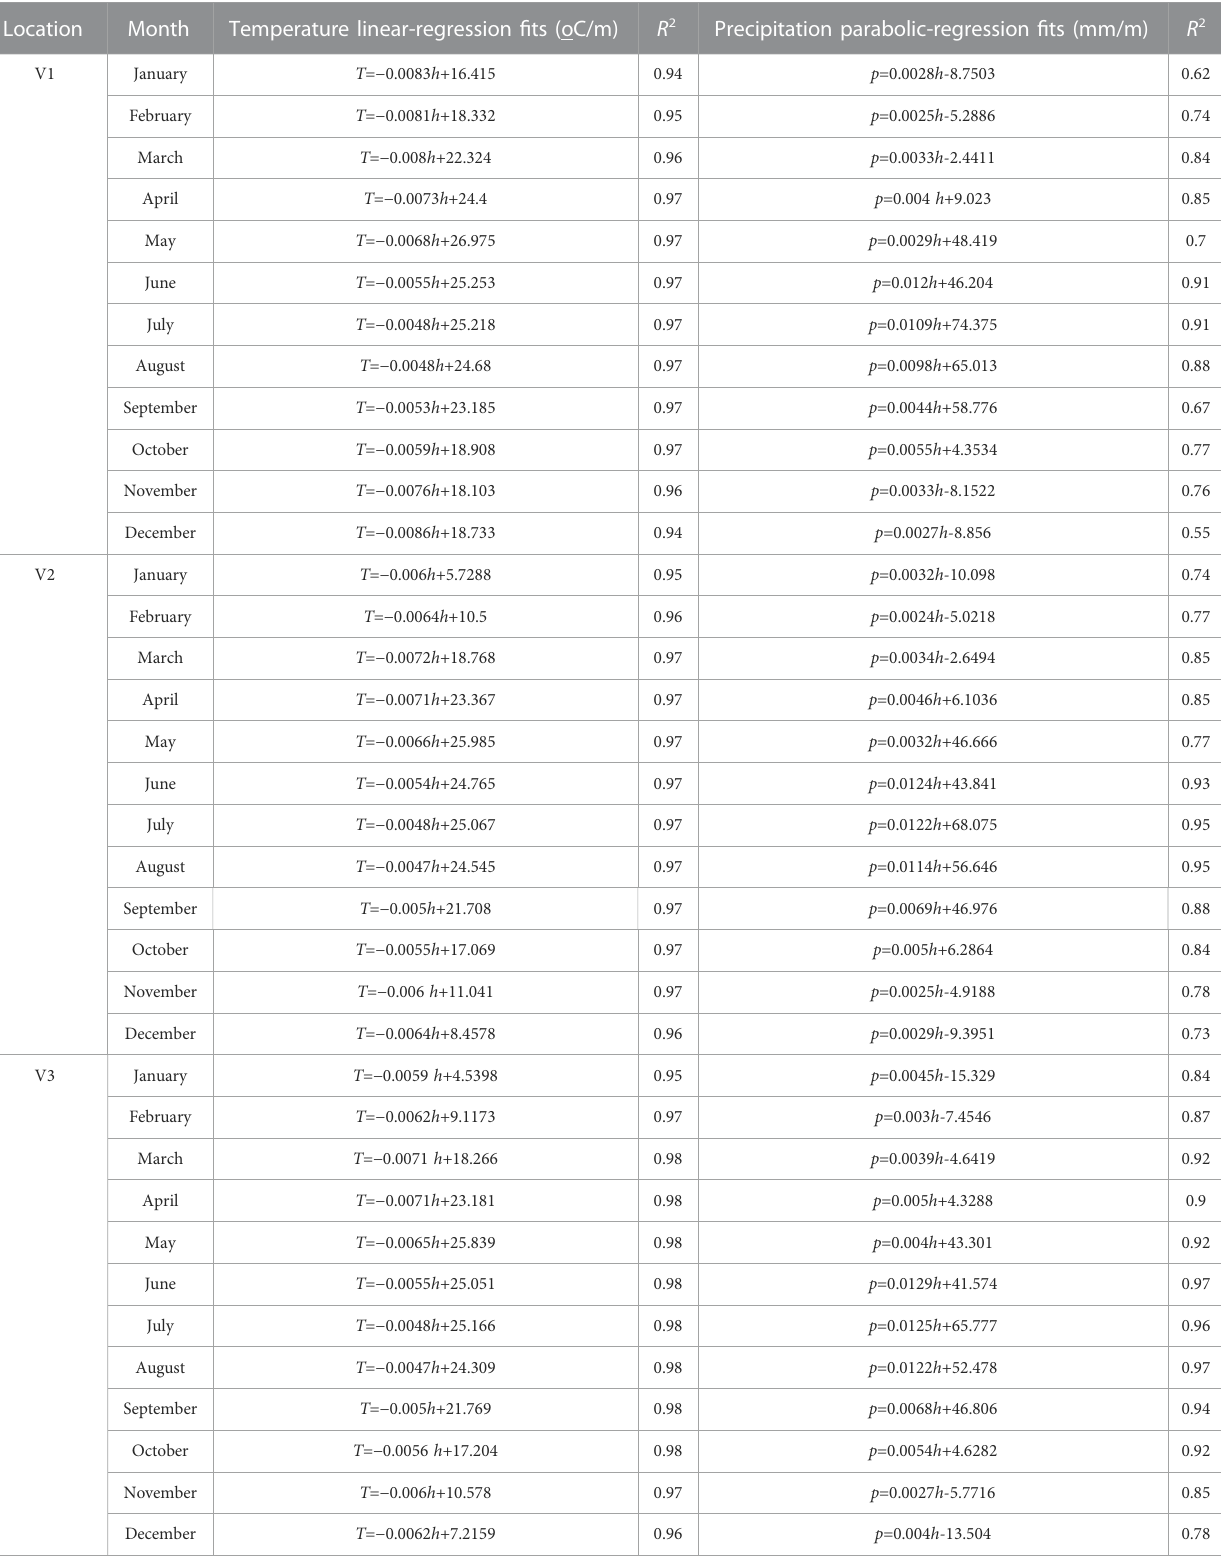
TABLE 2 Regression equations for the monthly mean climate data at the elevation used to simulate the glacier mass balance over the entire model domain. Location Month Temperature linear-regression fi ts